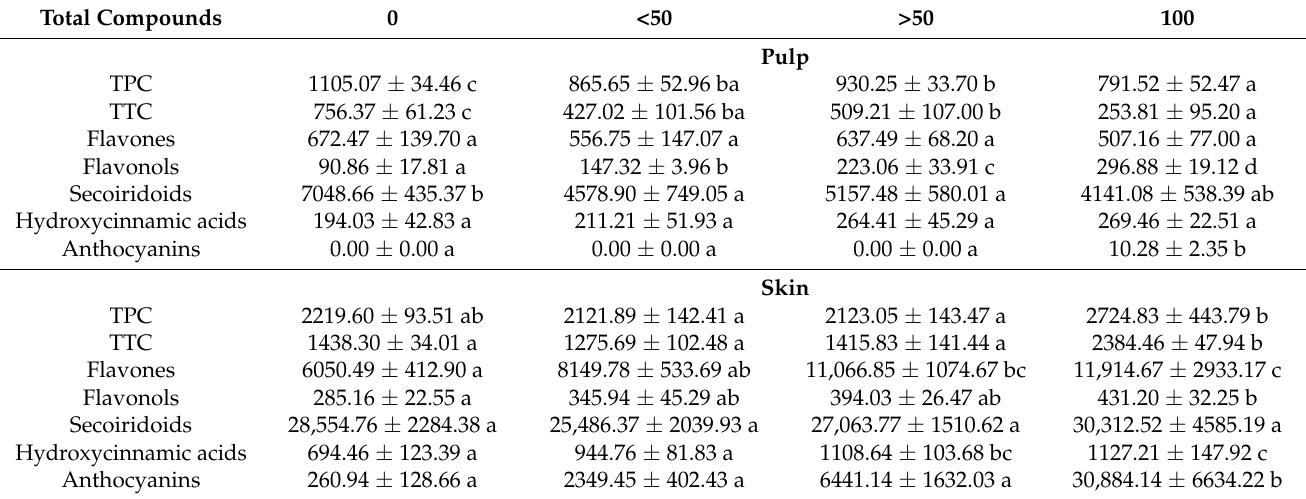
Table 3. TPC, TTC (mg/100 g FW) and sum contents of flavones, flavonols, secoiridoids, hydroxycin- namic acids and anthocyanins in olives pulp and skin during ripening (mg/kg